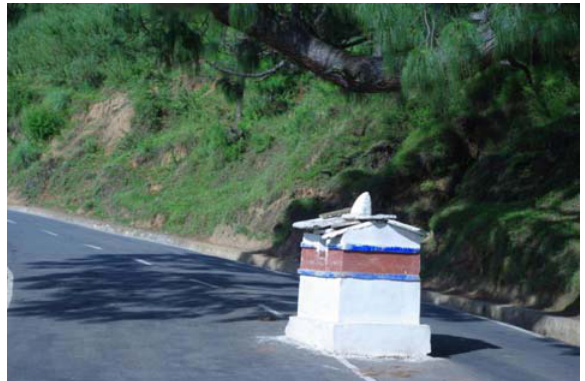
Figure 3. Cholten on a road near